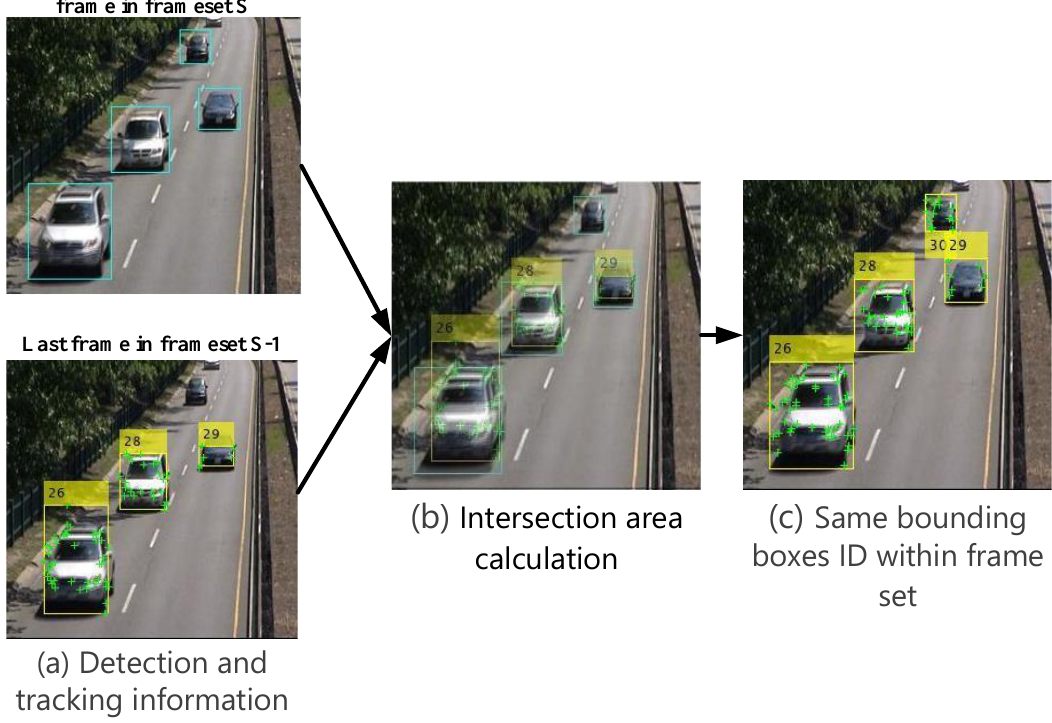
Figure 5. Connecting vehicles